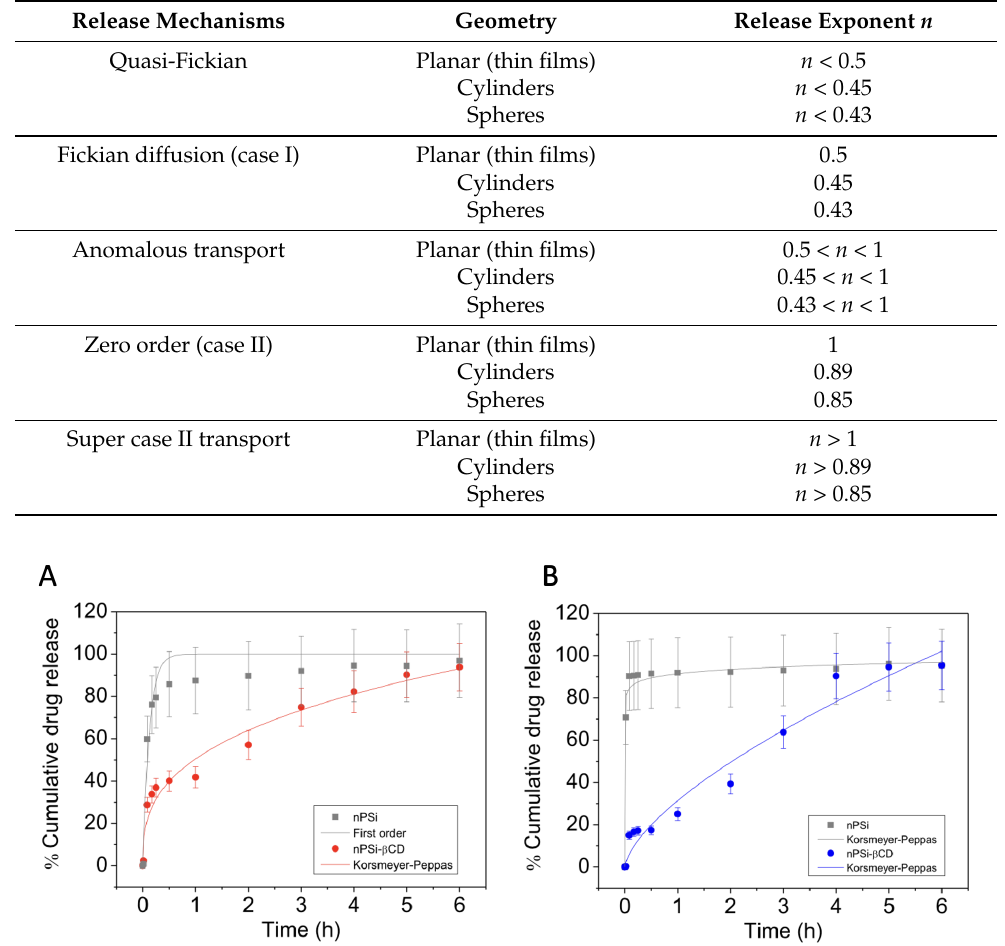
Figure 7. Polyphenols release profiles from porous silicon (control) and porous silicon coated with β - CD/CTR in phosphate-buffered saline (PBS) at 37 ºC. ( A ) Caffeic acid, and ( B ) pinocembrin. Adapted from [69], with permission from